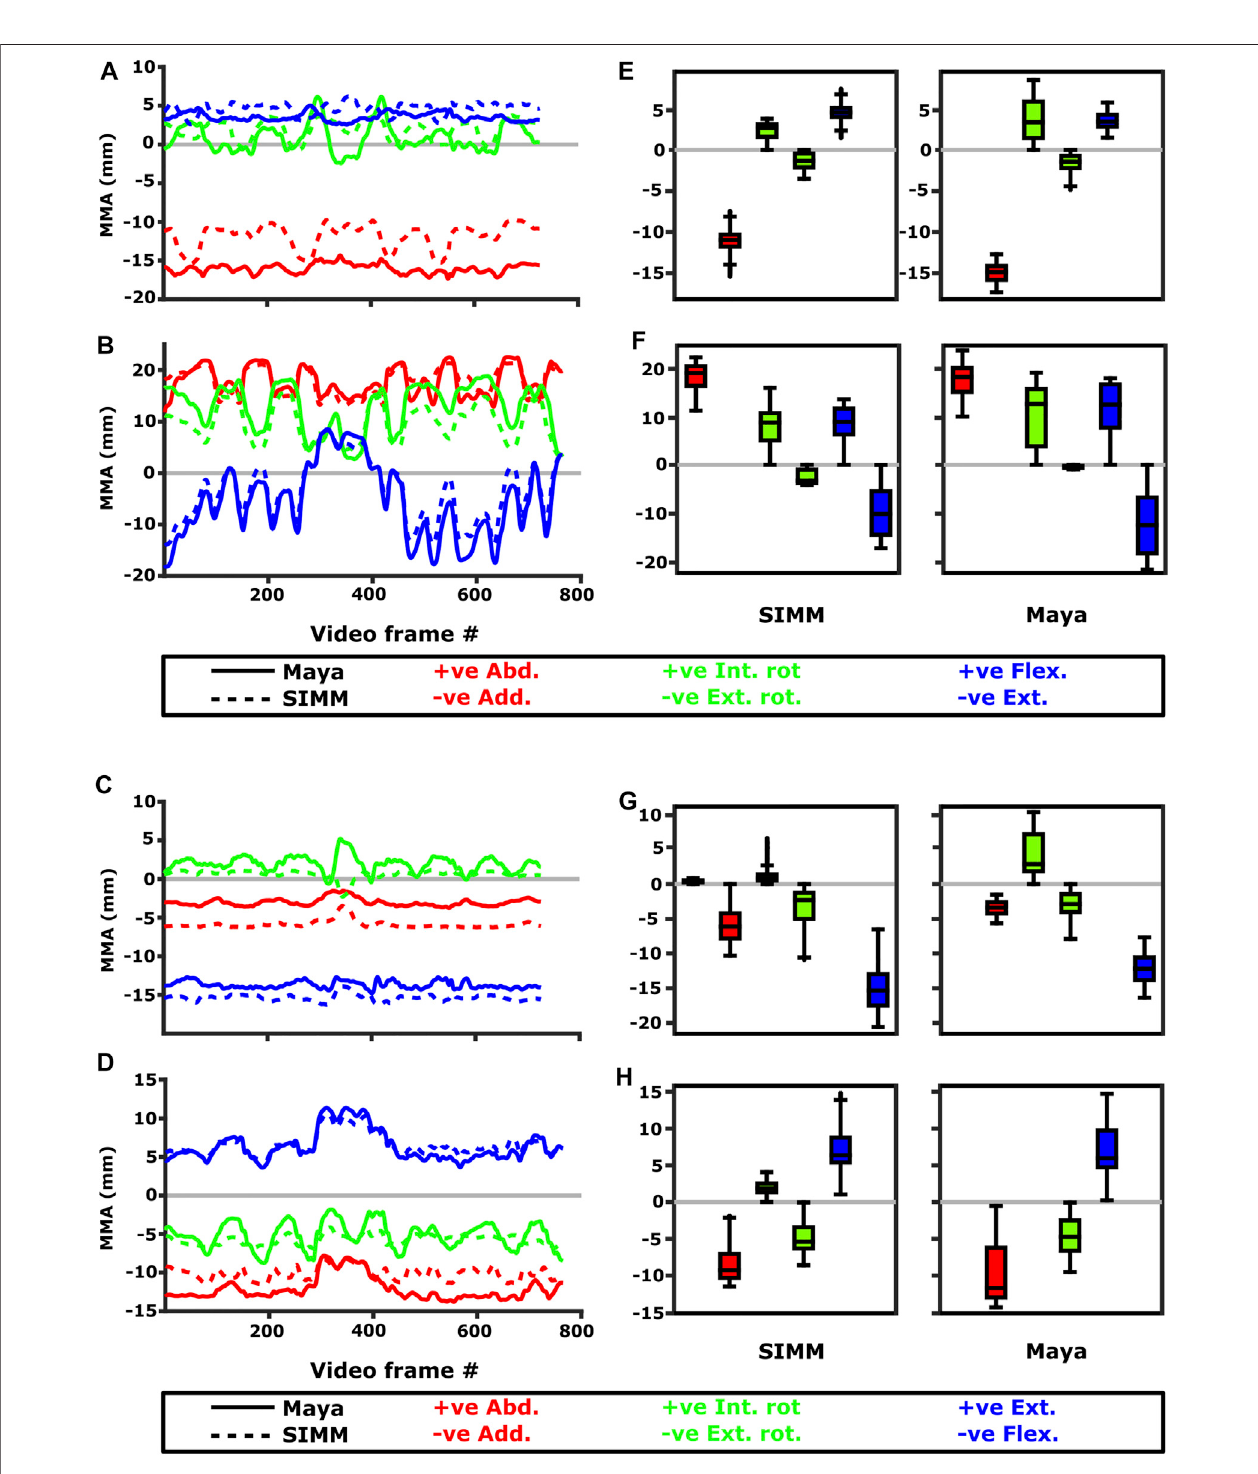
FIGURE 11 | Representative kinematic trials (left) and frequency distributions of MMAs for all kinematic trials (right) crossing the glenohumeral (top) and humeroradioulnarjoints (bottom).Representativetrialsfor (A) m.bicepsbrachiiatglenohumeraljoint, (B) m.tricepsbrachiiatglenohumeraljoint, (C) m.bicepsbrachiiat humeroradioulnar joint, (D) m. triceps brachii at humeroradioulnar joint. The boxplots (E – H) show the distribution and median values of MMAs for all trials: (E) m. biceps brachii at glenohumeral joint, (F) m. triceps brachii at glenohumeral joint, (G) m. biceps brachiiat humeroradioulnar joint, (H) m. triceps brachii at humeroradioulnar joint. Positive and negative MMAs are plotted as separate boxplots for each DOF. SIMM (cid:3) model-predicted MMAs based on partial velocity; Maya (cid:3) experimentally- calculated MMAs based on the geometric method.